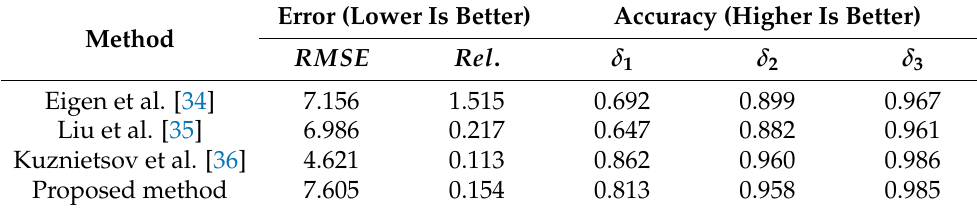
Table 4. Comparison to the other methods using KITTI dataset.